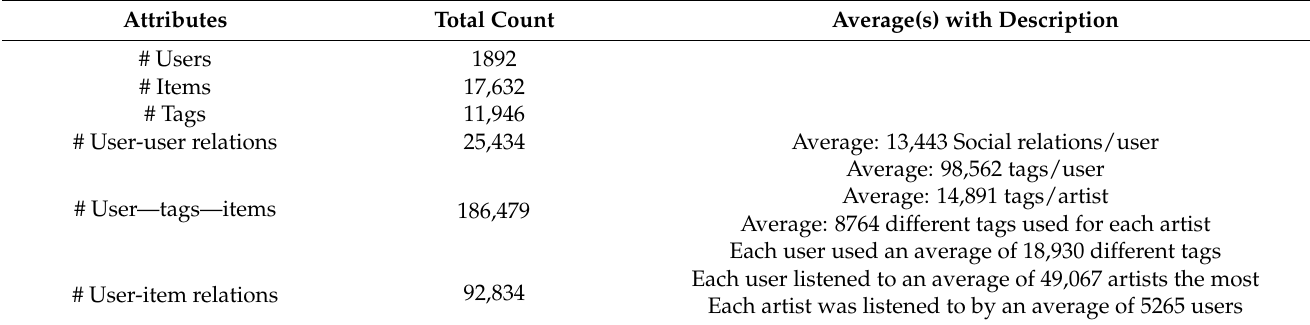
Table 1. Description of the Lastfm